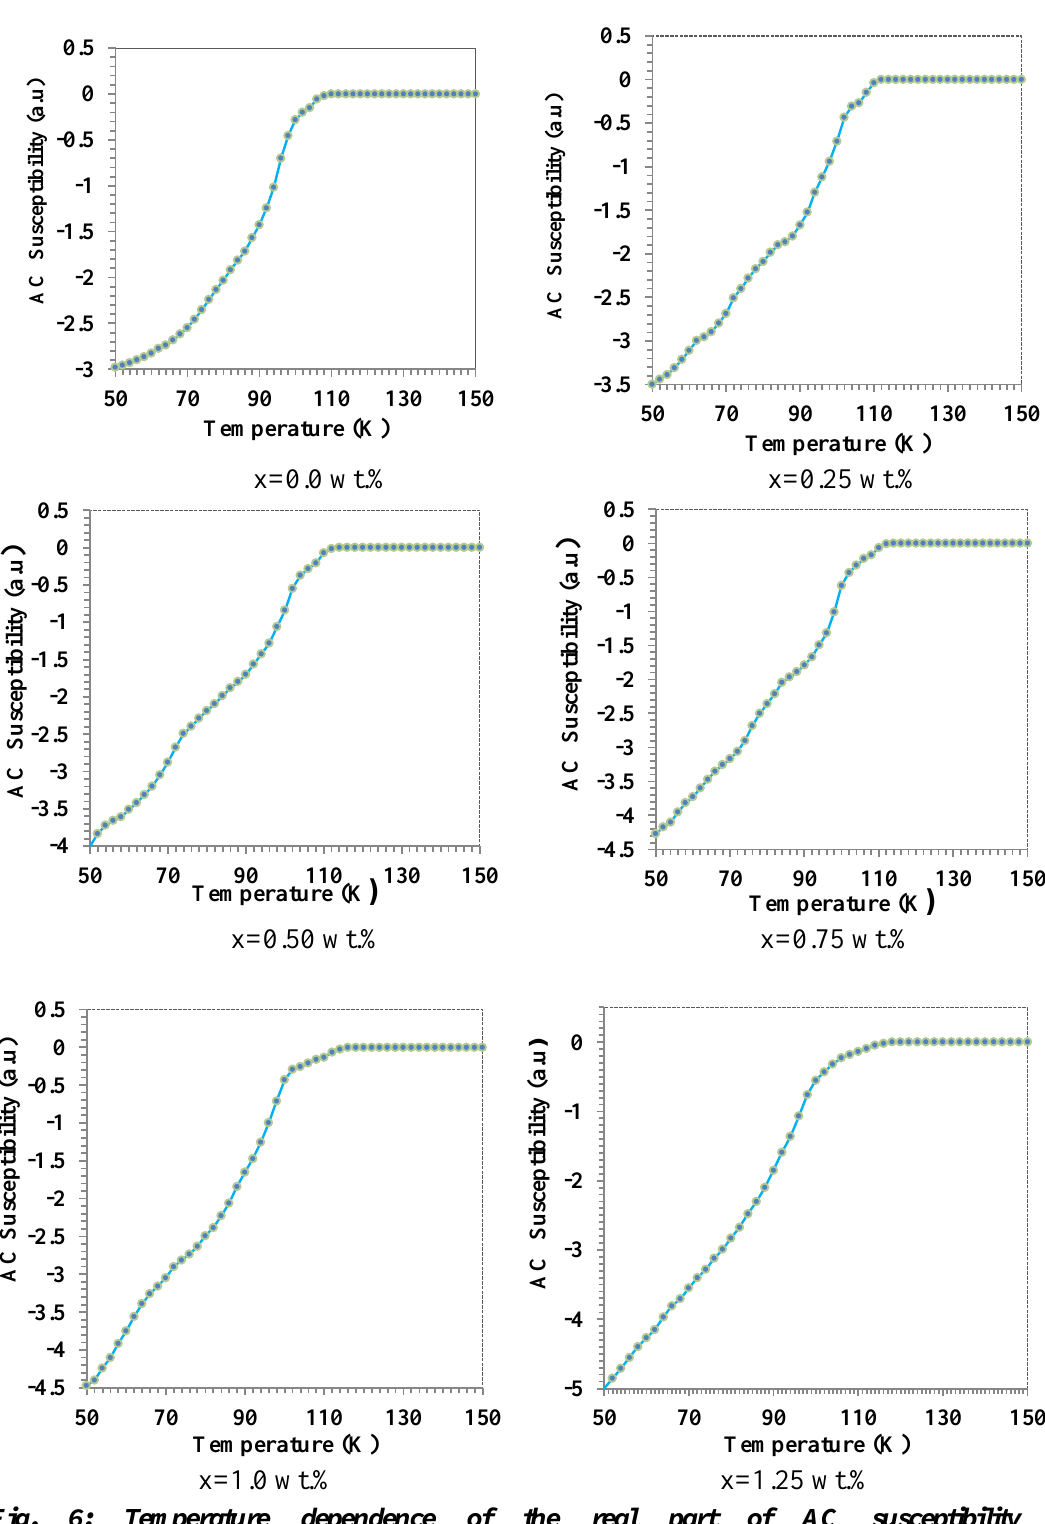
6: Temperature dependence of the real part of AC susceptibility of (Au) Bi Pb Sr Ca Cu O samples with x = 0 - 1.25 x 1.6 0.4 2 2 3 10+δ